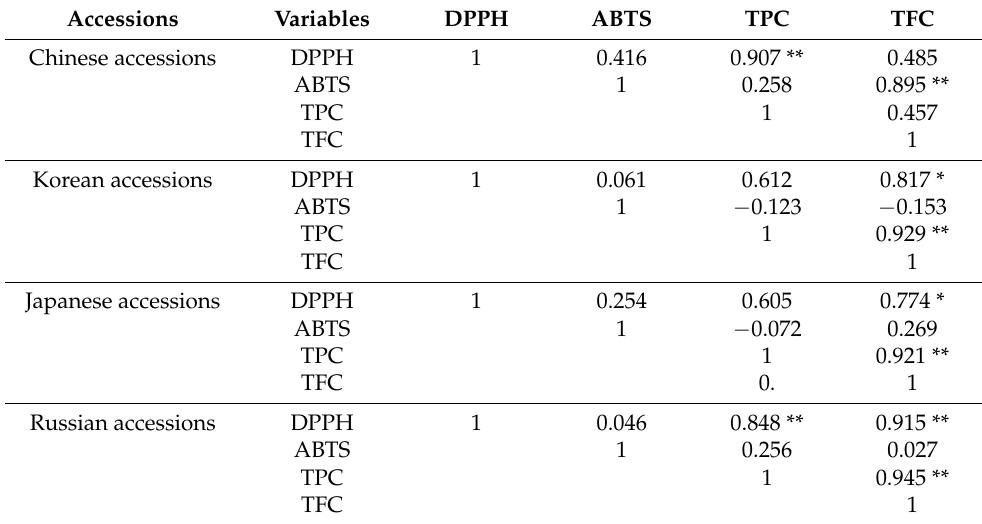
Table 8. Pearson’s correlation coefficients between the antioxidant potential, total phenolic content, and total flavonoid content in selected M. sacchariflorus